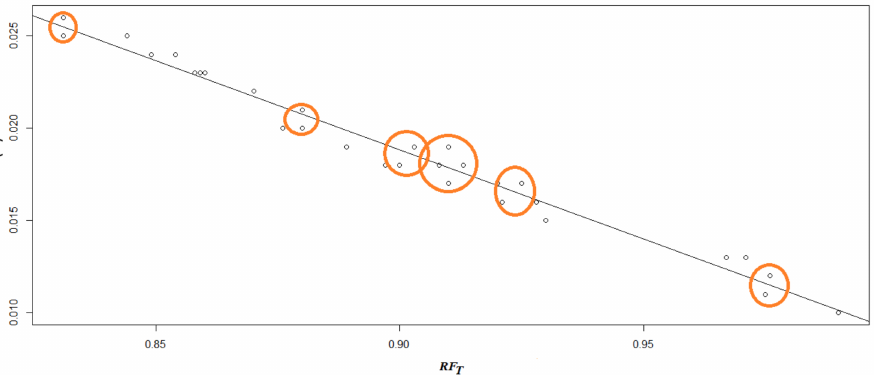
Figure 5. Behavior of the convergence time t conv of the Convection-Diffusion problem depending on the relaxation